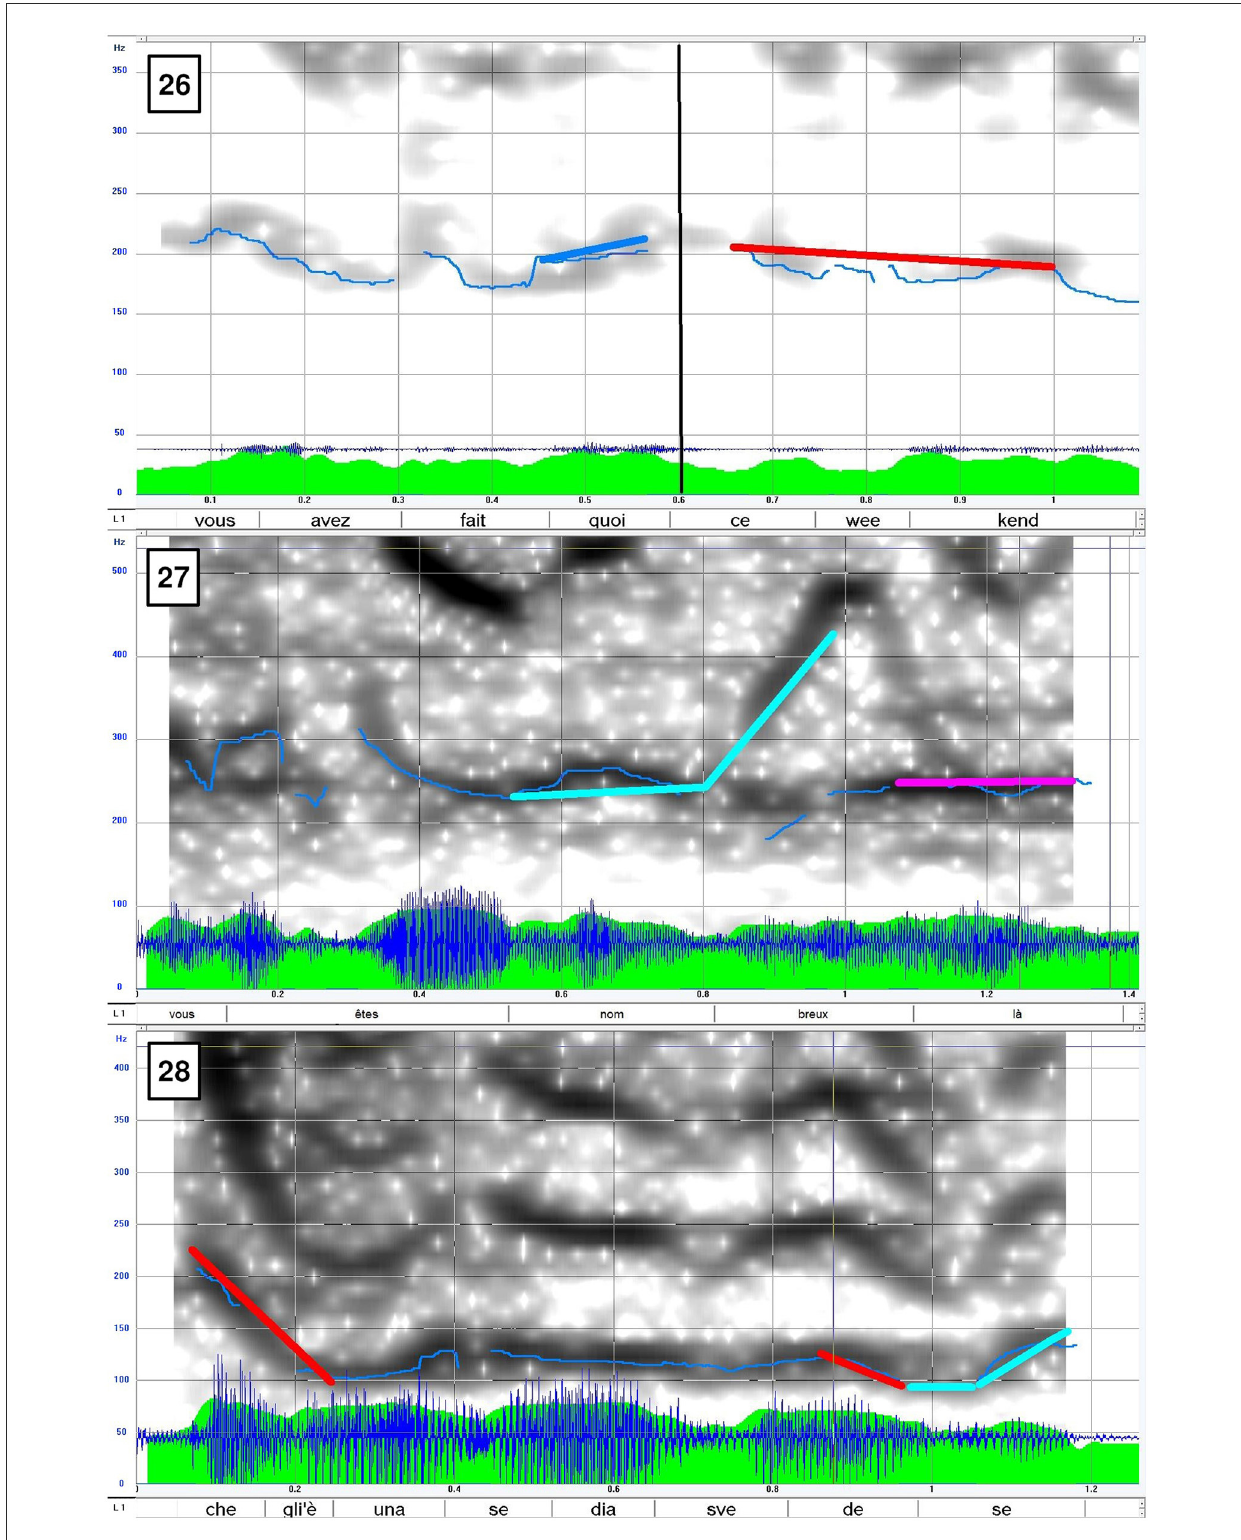
FIGURE14 Prototypic contours of Double questions in French and Italian (26–28) (Supplementary Audio